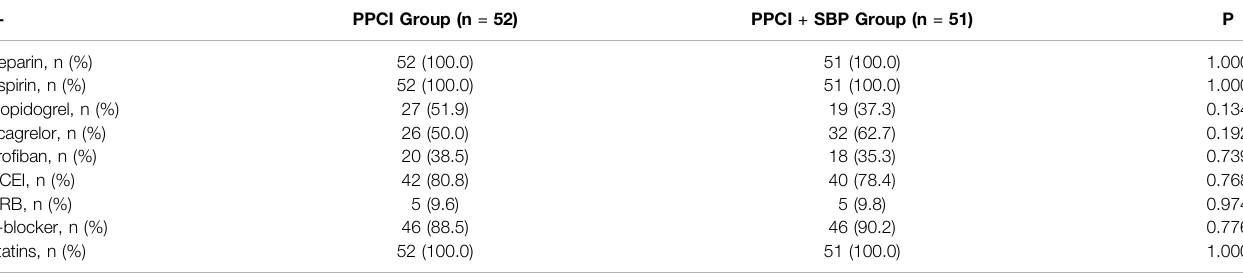
TABLE 2 | Comparison of preoperative, intraoperative and postoperative medication between PPCI + SBP and PPCI. — PPCI Group (n = 52) PPCI + SBP Group (n = 51) P heparin, n (%)